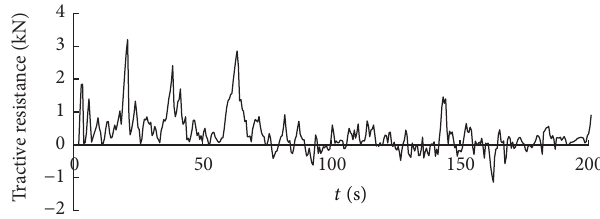
Figure 5: Time history curve of tractive resistance on cutting